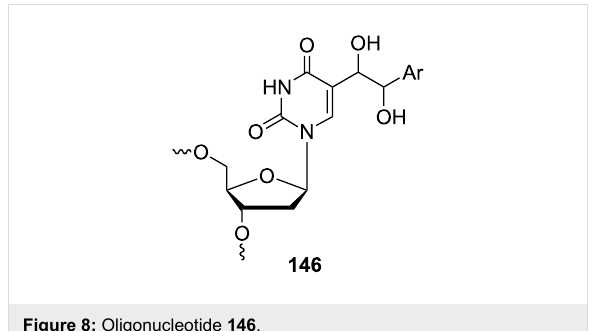
Figure 8: Oligonucleotide 146